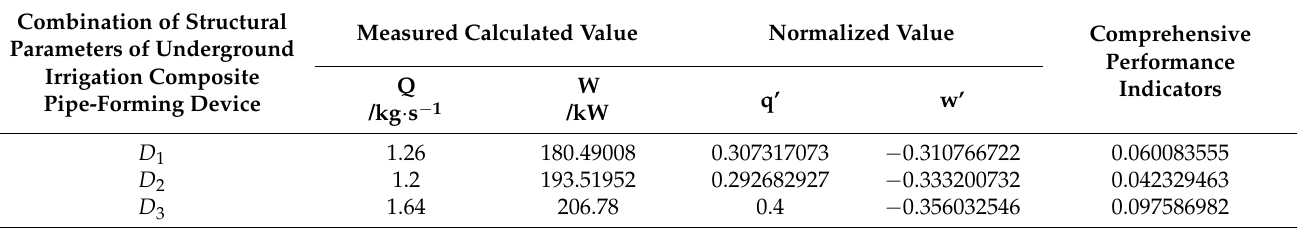
Table 3. Comprehensive performance calculations of test